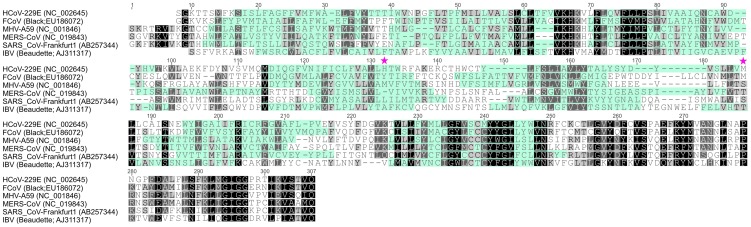
Alignment of coronavirus nsp6 sequences.Alignment of nsp6 sequences derived from coronaviruses used in this study was performed with Geneious Software (Biomatters Ltd, New Zealand). Coronavirus species and corresponding GenBank accession numbers are indicated. Membrane domains predicted by TMHMM Server v. 2.0 (http://www.cbs.dtu.dk/services/TMHMM/) are indicated by cyan shading while conserved amino acid residues are highlighted by black/grey shading. K22 resistance-conferring mutations in HCoV-229E nsp6, identified in this study, are depicted.